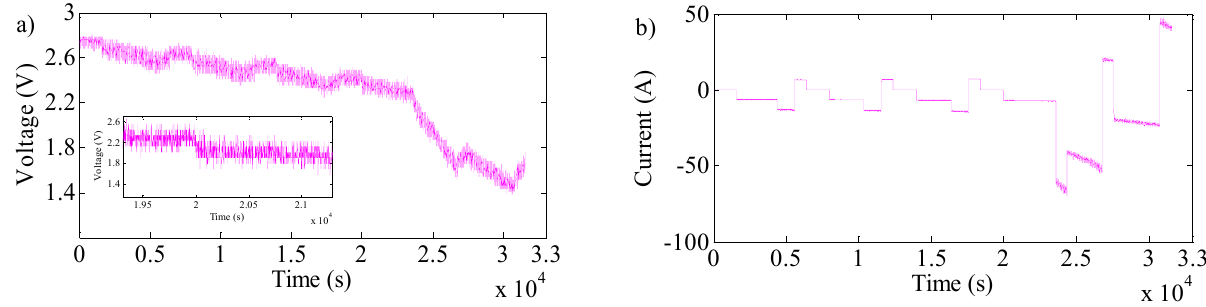
Figure 4. The measured voltage ( a ) and current ( b ) profiles in the DST